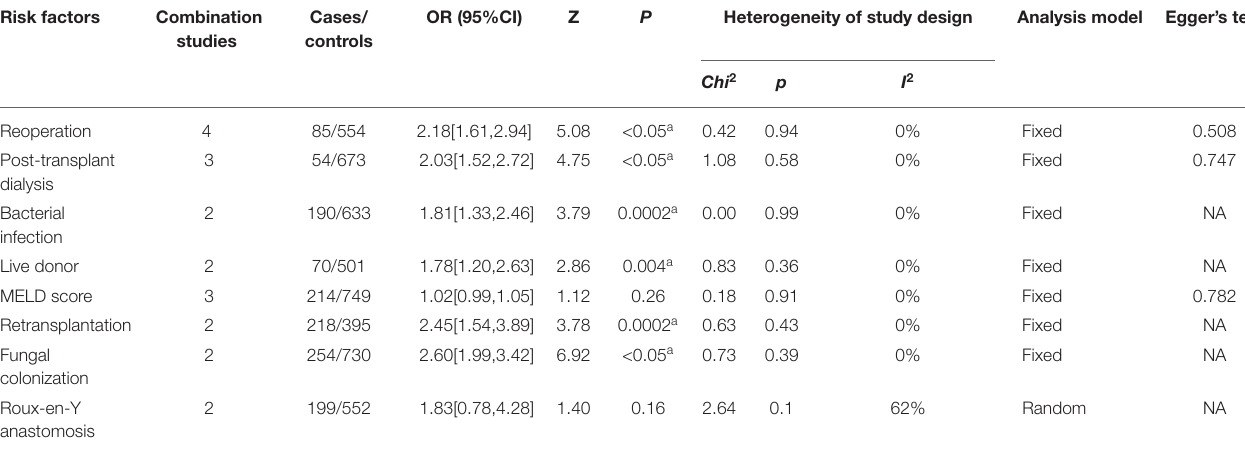
TABLE 2 | Meta-analysis of risk factors of invasive fungal infection in recipients after liver